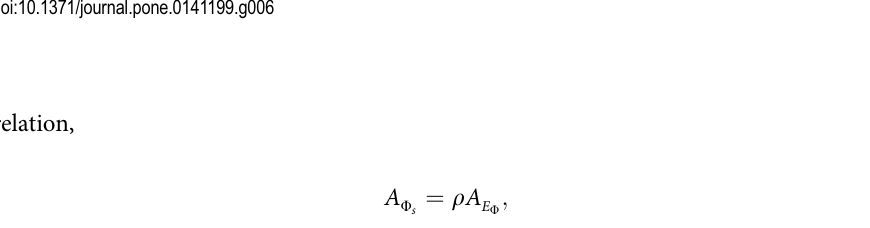
Fig 6. An open dataset (237 images) to test the assumption in Eq